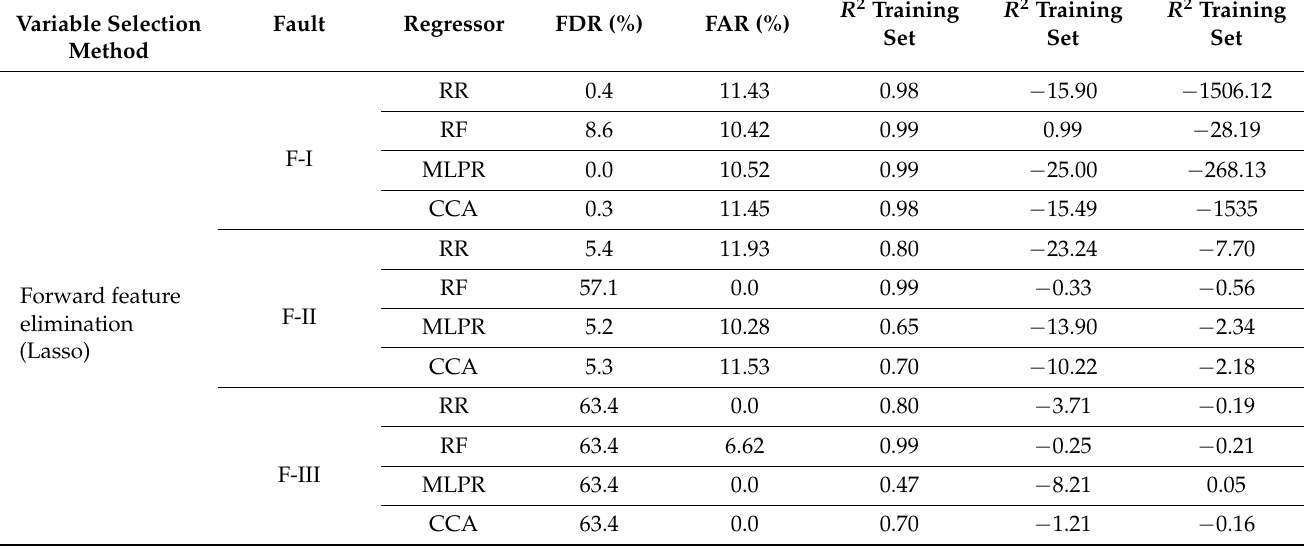
Table 8. Performance when wrapper-based variable selection procedures were used to analyze the industrial data. Variable Selection Method